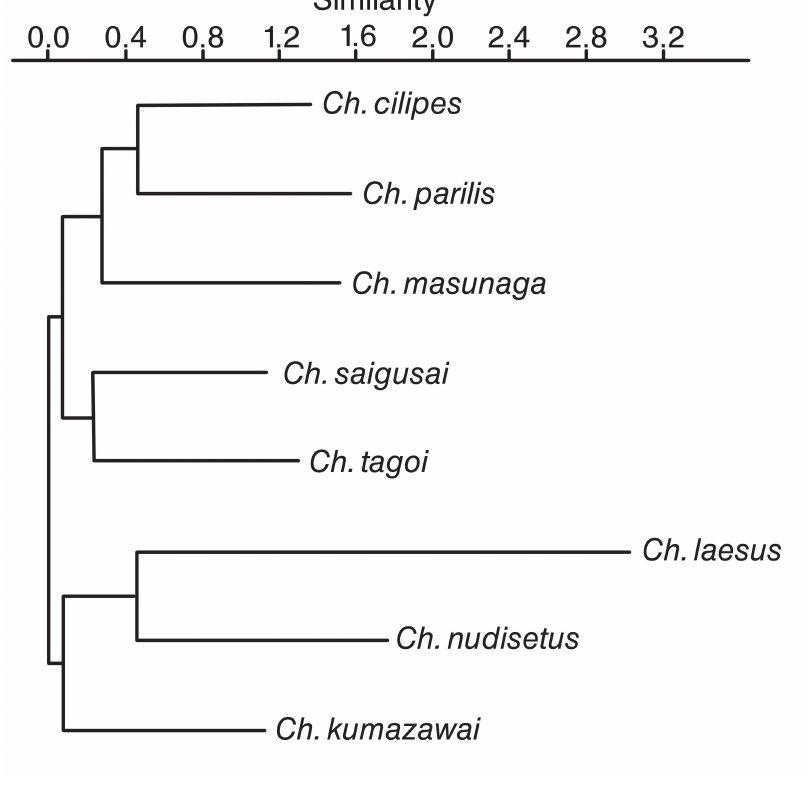
Fig. 6. Consensus cladistic tree of 6 equally parsimonious trees obtained from 20 morphological characters for the Chrysotus Meigen, 1824 species from